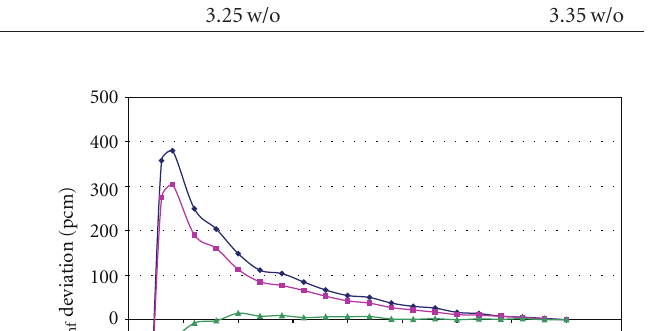
Table 5: PB-2 fuel pin—NEWT results for reference model.